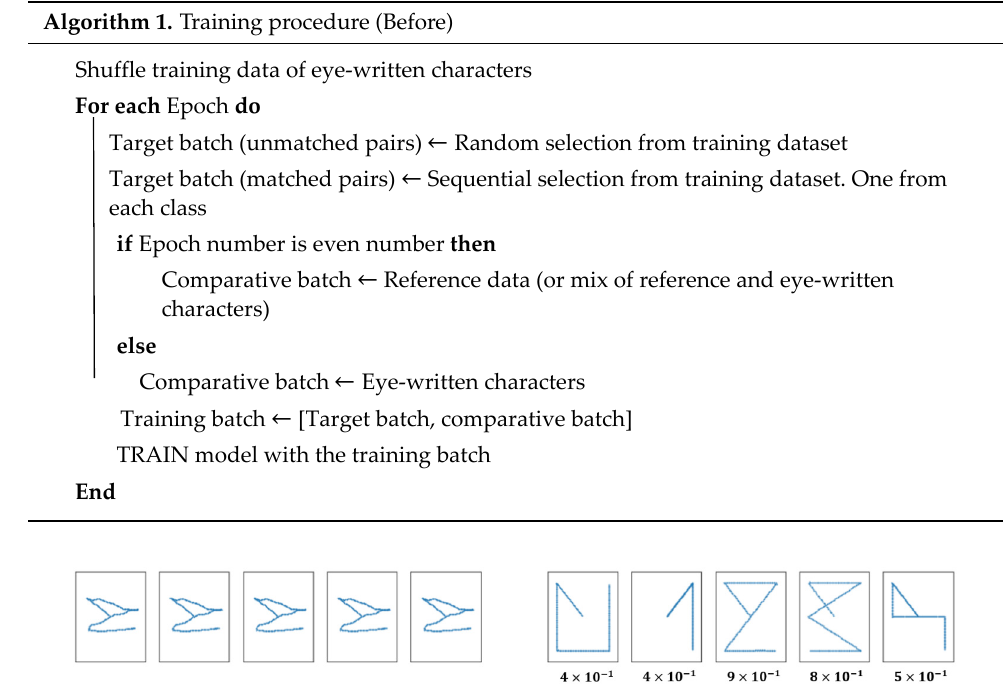
Algorithm 1. Training procedure (Before)